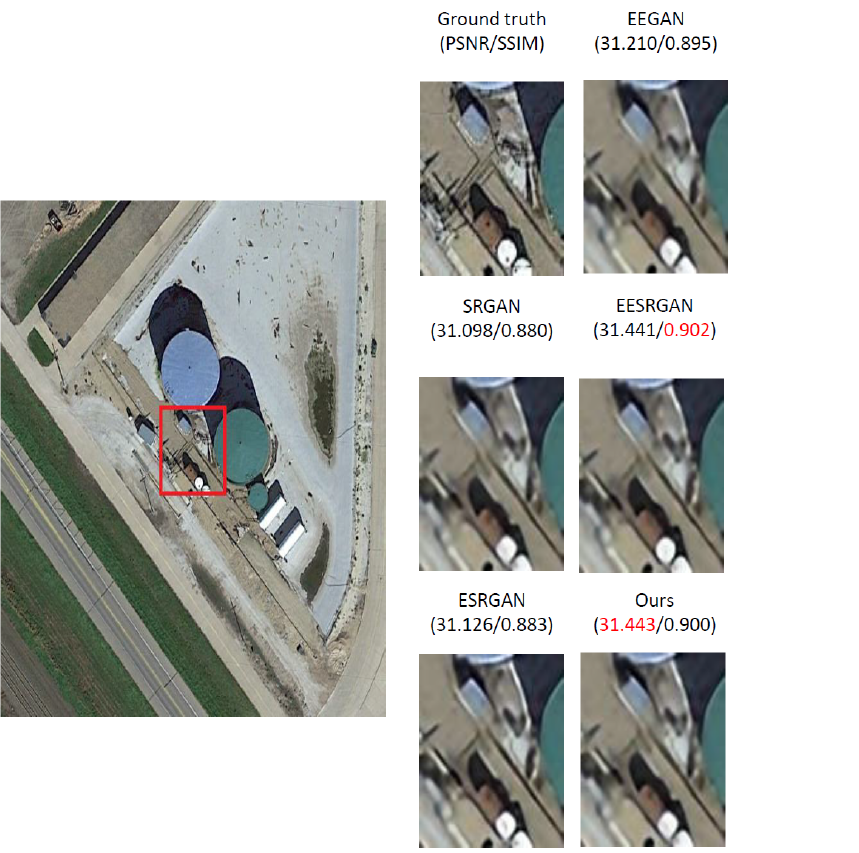
Figure 10. An enlarged partial view of the SR result of each method in the AID dataset, where the best results are shown in red font.